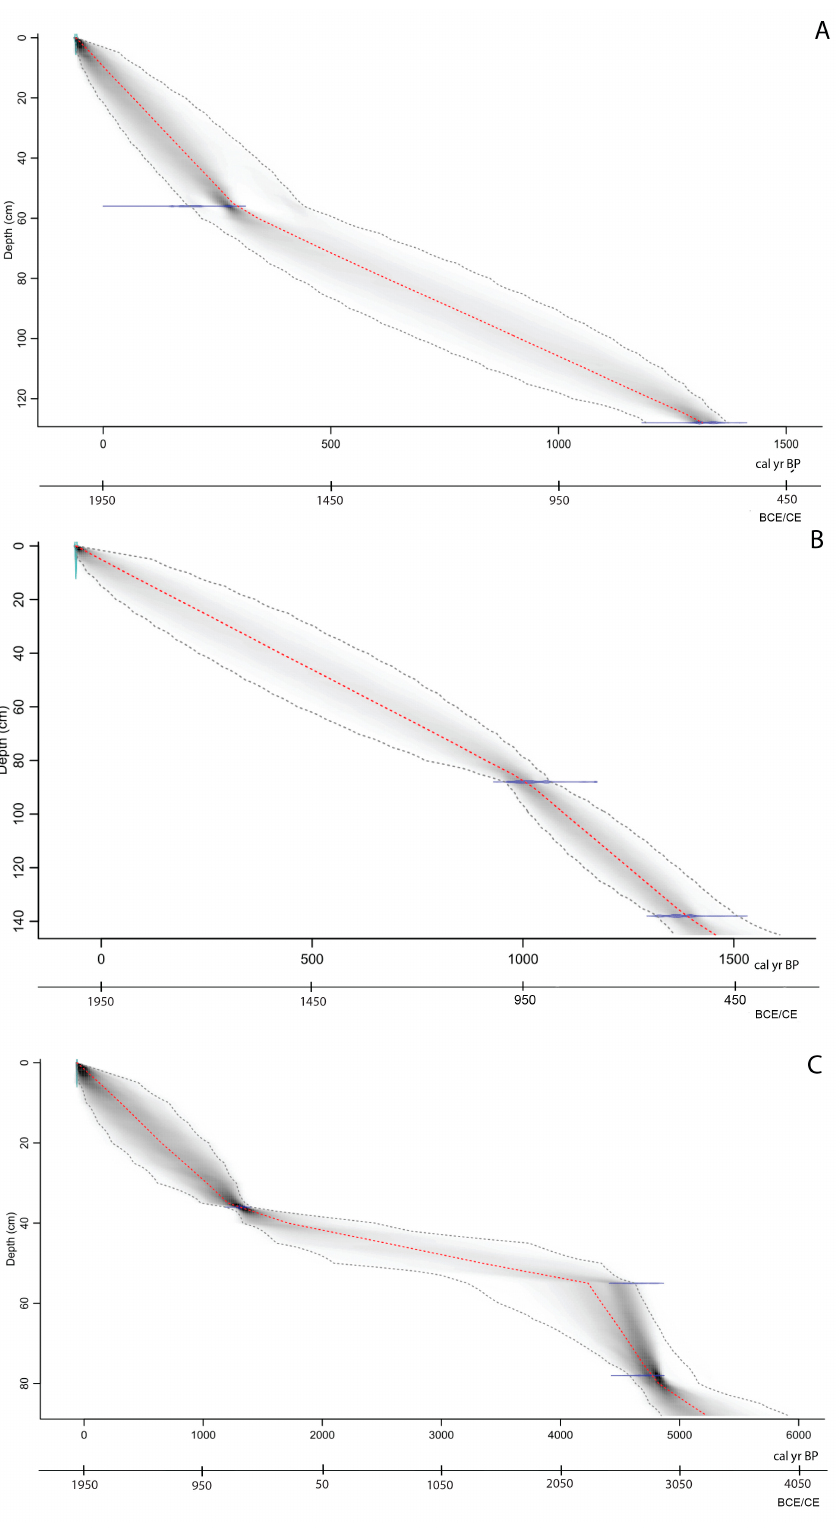
Figure 3. An age–depth model of the ( A ) AUU1, ( B ) BUU1 and ( C ) CUU1 cores. The sedimentation rate in the lower part of core AUU1 is 0.69 mm yr − 1 (128–56 cm), increasing in the upper part to 1.66 mm yr − 1 (56–0 cm). The sedimentation rate of BUU1 in the lower part (138–88 cm) is 1.31 mm yr − 1 and the rate of the upper part is 0.83 mm yr − 1 (0–88 cm). The sedimentation rates in the lower, middle and upper part of CUU1 are 0.52 (55–78 cm), 0.11 (36–55 cm) and 0.26 (0–36 cm) mm yr − 1 , respectively.